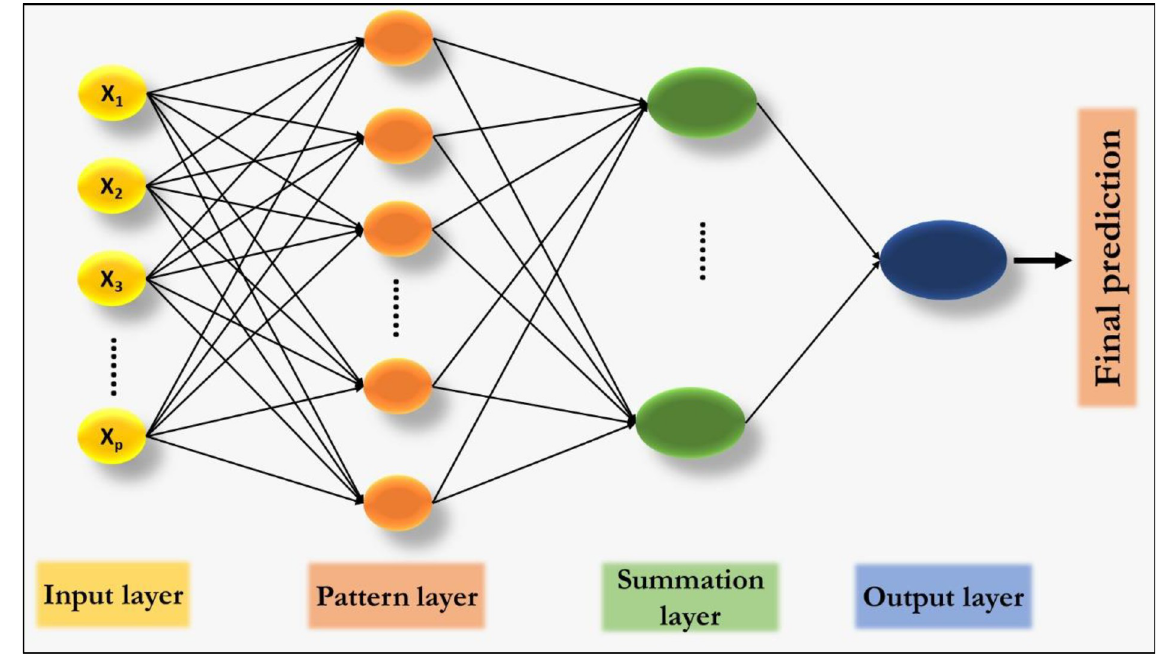
Fig 4. The schematic representation of